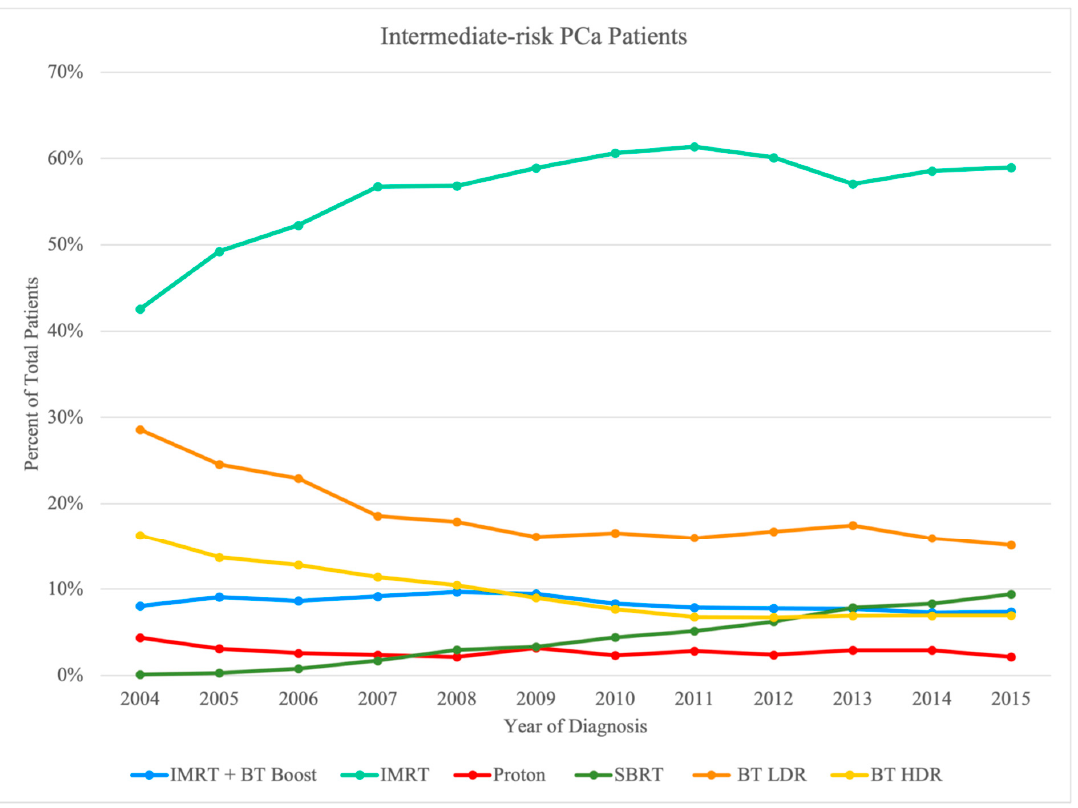
Figure 3. Pattern of utilization of radiation therapy modality for intermediate-risk PCa patients by treatment modality.